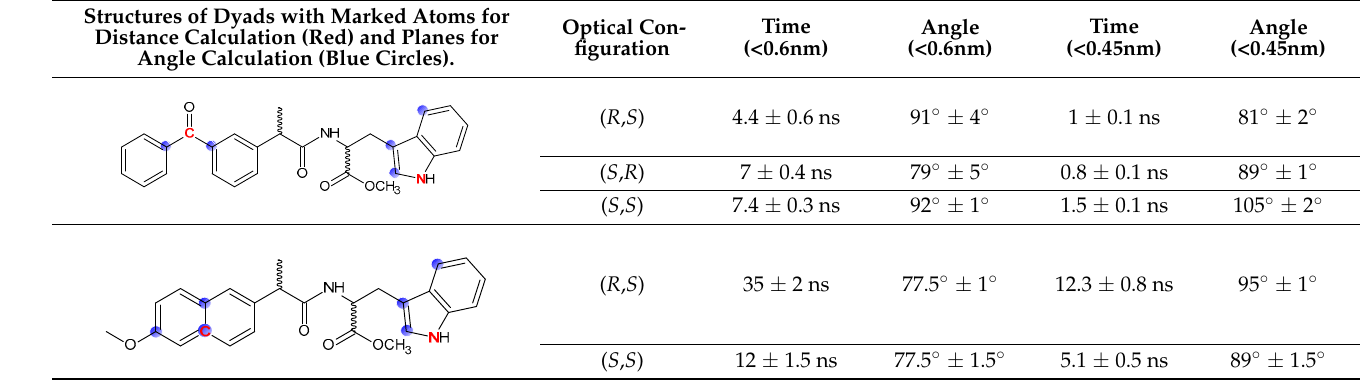
Table 6. The values of contact times of donor and acceptor moieties at the distances less than 0.6 and 0.45 nm for ( R,S )-, ( S,R )- and ( S,S )-configuration of dyads I-II and angles between plane of donor and acceptor in the solution of acetonitrile (mean values from 10 trajectories with the duration of 100 ns) [20].